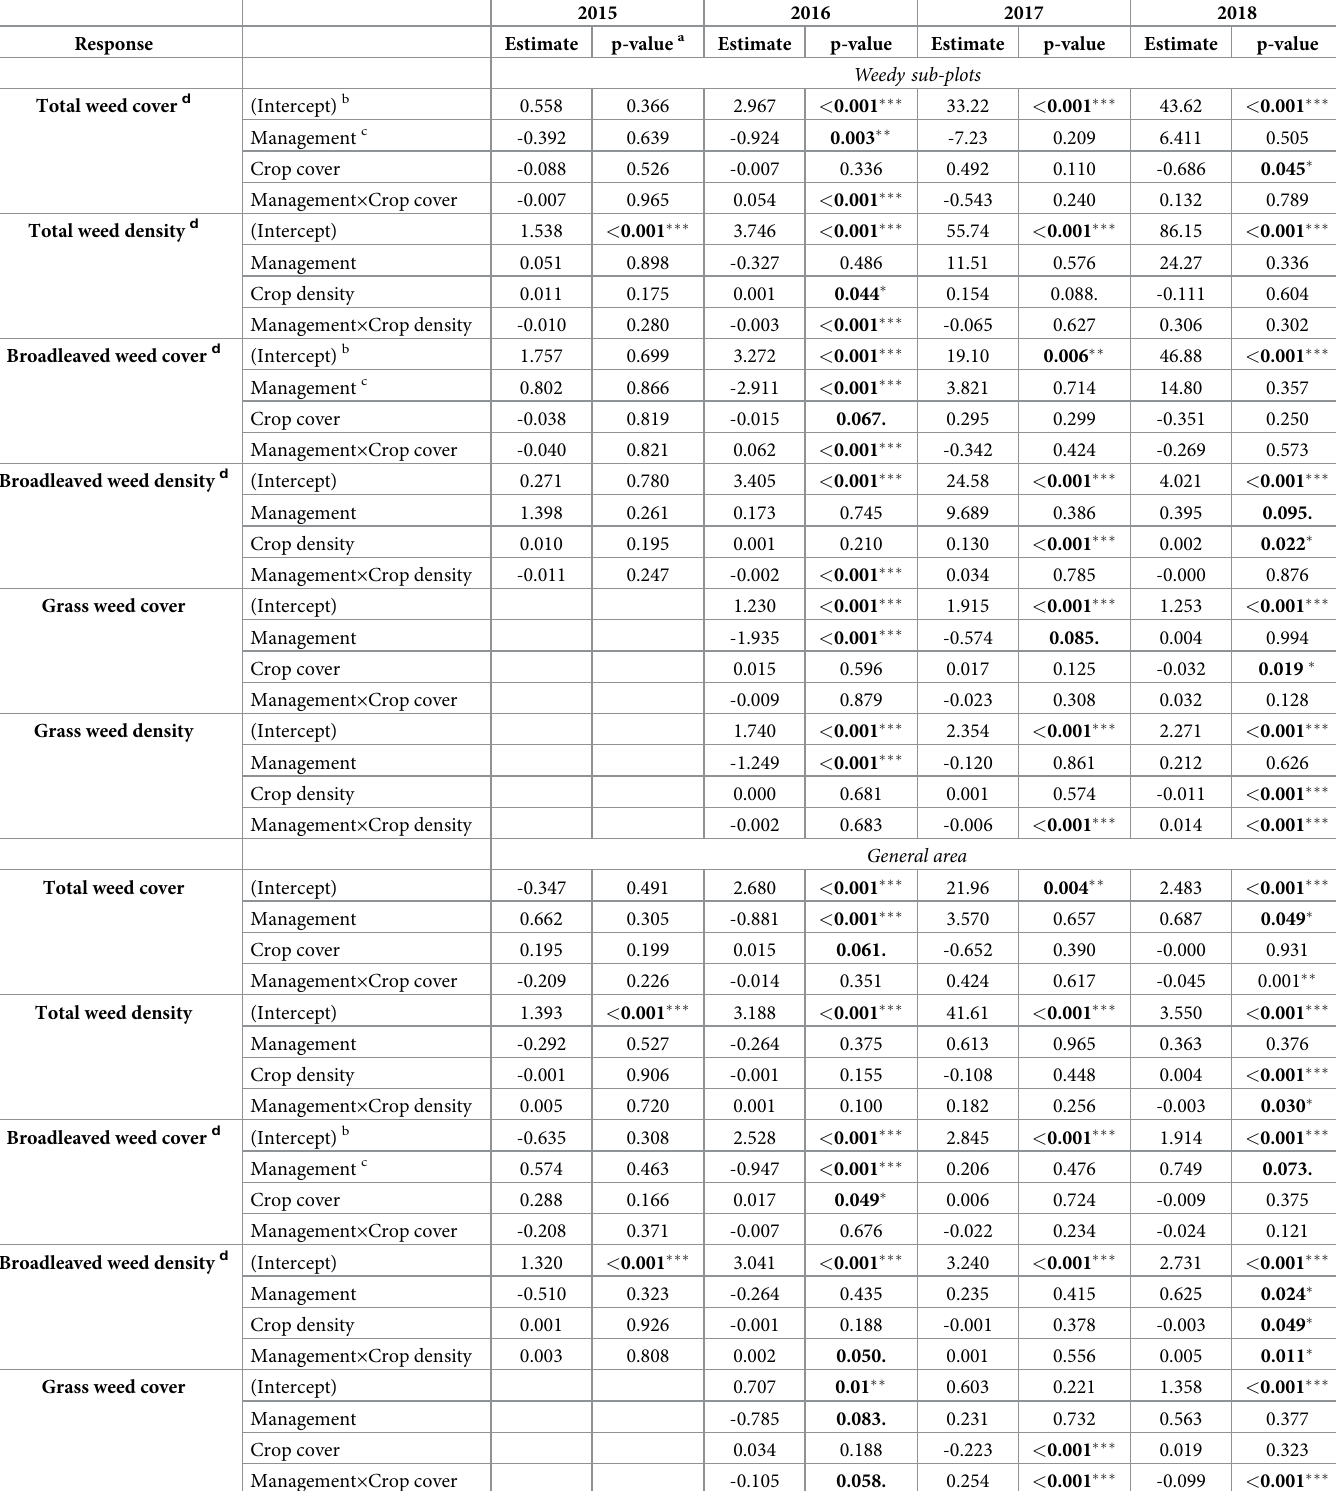
Table 4. Total weed, broadleaved, and grass weed cover and density by year as affected by fallow management and crop cover. Note: analysis for grasses in 2015 was not included because grasses were almost absent in